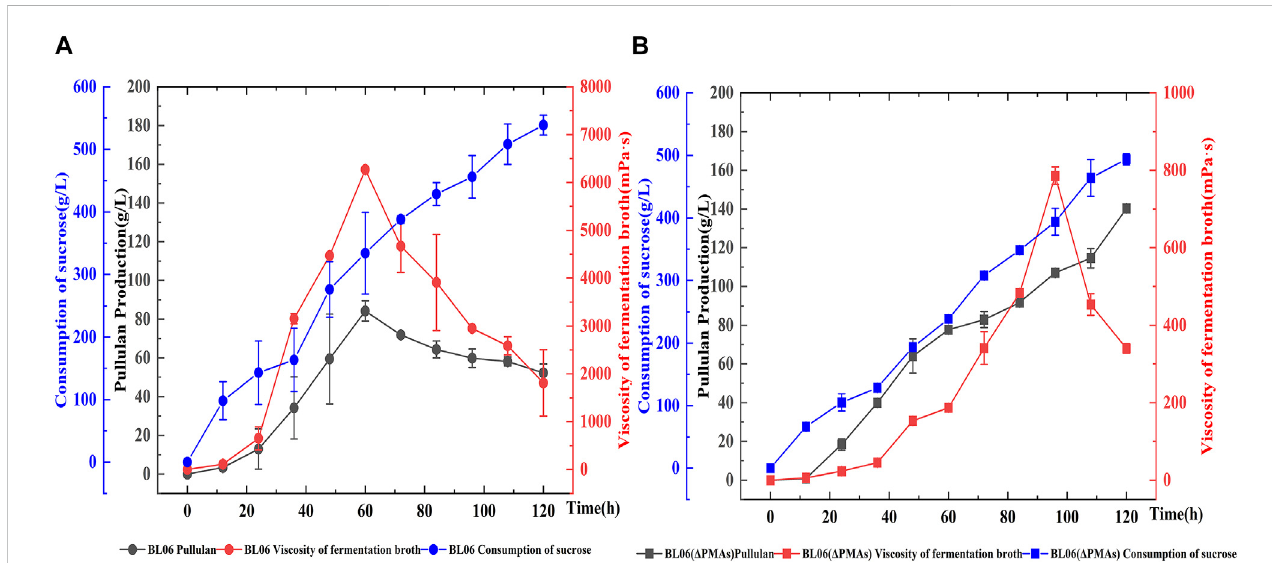
FIGURE 5 Batchfeedingfermentationof A.pullulans BL06 (A) and A.pullulans BL06 Δ PMAs (B) ina5 Lbioreactor.Theblacksolidcircleandsolidsquareindicatethe pullulan production by A. pullulans BL06 and A. pullulans BL06 Δ PMAs respectively; the red solid circle and solid square indicate the viscosity of the fermentation broth of A. pullulans BL06 and A. pullulans BL06 Δ PMAs respectively; the blue solid circle and solid square indicate the consumption of sucrose by A. pullulans BL06 and A. pullulans BL06 Δ PMAs respectively. All values are expressed as the means ± SDs ( n =